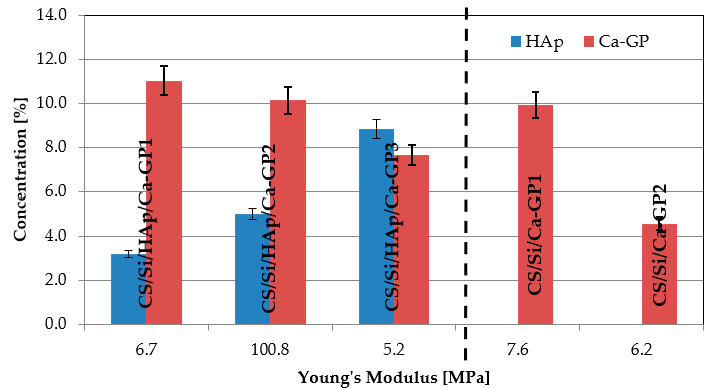
Figure 5. Influence of hydroxyapatite and Ca-GP on Young’s modulus (labels above each compo- site) for drying samples at 100 °C.